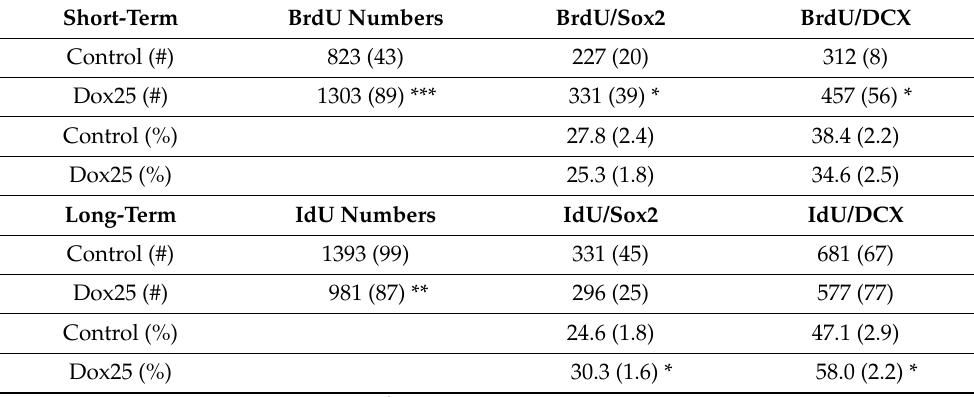
Table 1. Number and phenotypes of BrdU- and IdU-positive cells in the SGZ/GCL. BrdU- and IdU-positive cells co-expressing Sox2 (precursor cells, type-2) or DCX (transient immature neurons, type 2b/3). All data are shown as mean ± sem. GCL, granule cell layer, SGZ, subgranular zone, (#) numbers, (%)